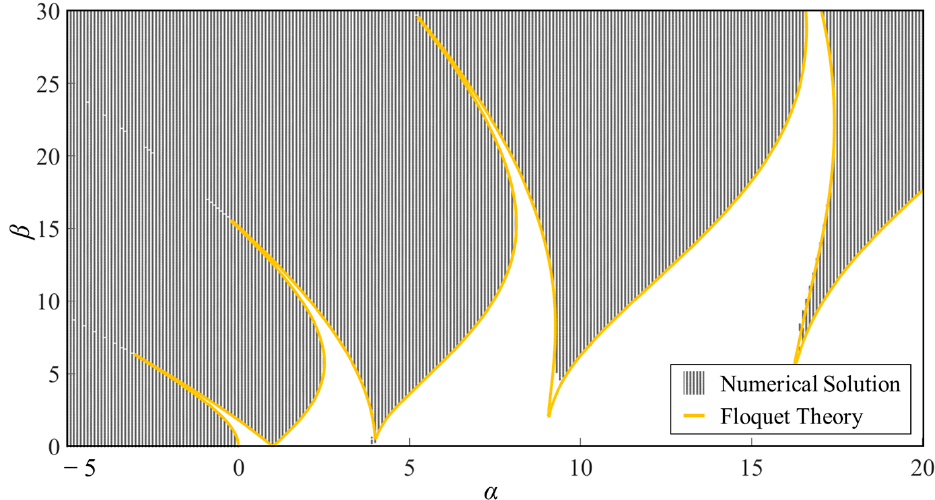
Figure 8. The instability chart of the Mathieu equation.